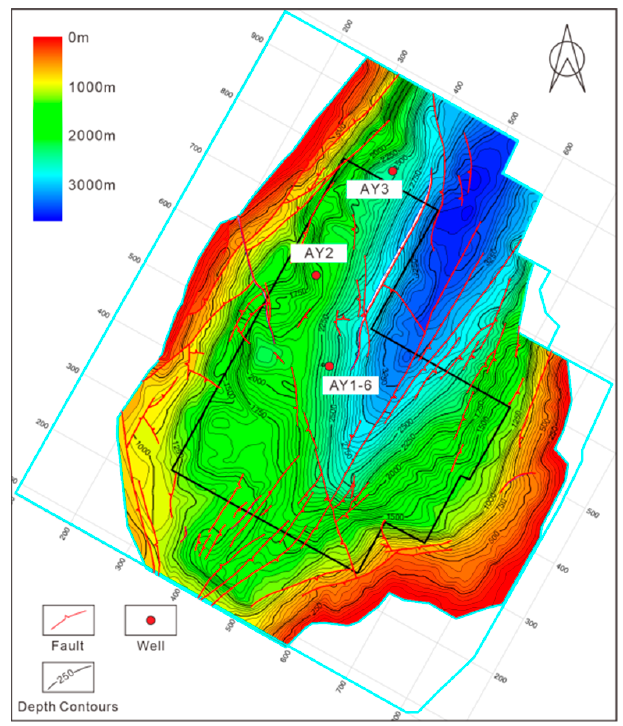
Figure 2. The geological structure about the bottom boundary of the Wufeng–Longmaxi Formation in the Anchang syncline in the northern Guizhou area. AY1-6, AY2, and AY3 are shale gas wells.